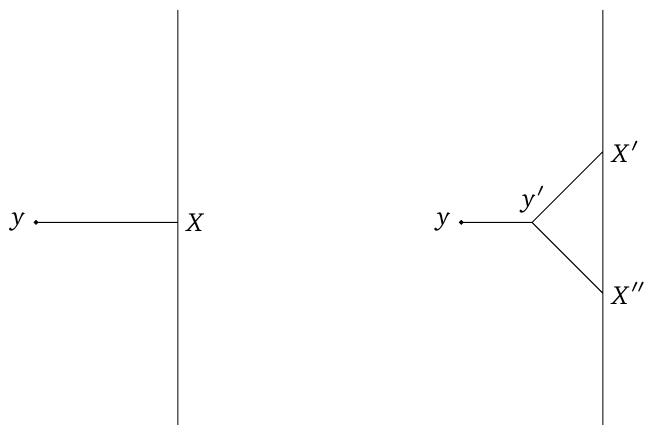
Figure 3: Diagrammatic representation of perturbative bulk reconstruction. The first diagram corresponds to the 0th order representation while the second corresponds to the first order correction in 1 / N